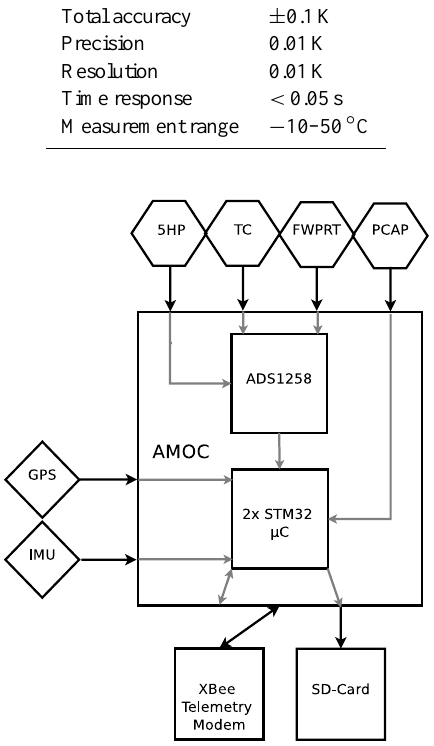
Fig. 1. Block diagram of the meteorological measuring unit for small RPA of type MASC (Multipurpose Airborne Sensor Carrier), developed at the University of T¨ubingen.